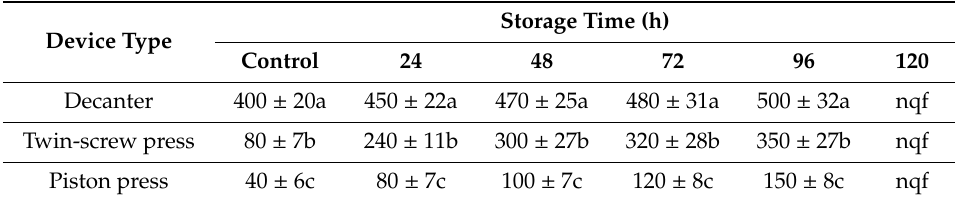
Table 1. Total number of mesophilic microorganisms (colony forming units (cfu) / mL) in apple juice obtained with various devices stored at 4 ◦ C. Di ff erent letters in the same column indicate values significantly di ff erent at P < 0.05.